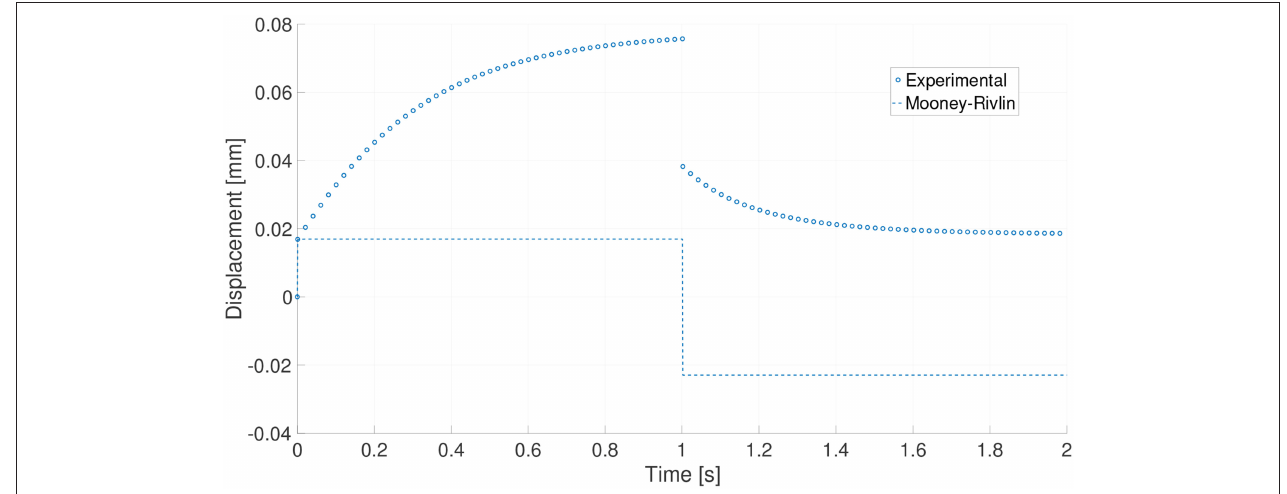
FIGURE 3 | Loading process for one particular experiment. Pseudo-experimental response and prediction made by the standard (non-viscous) Mooney-Rivlin material.